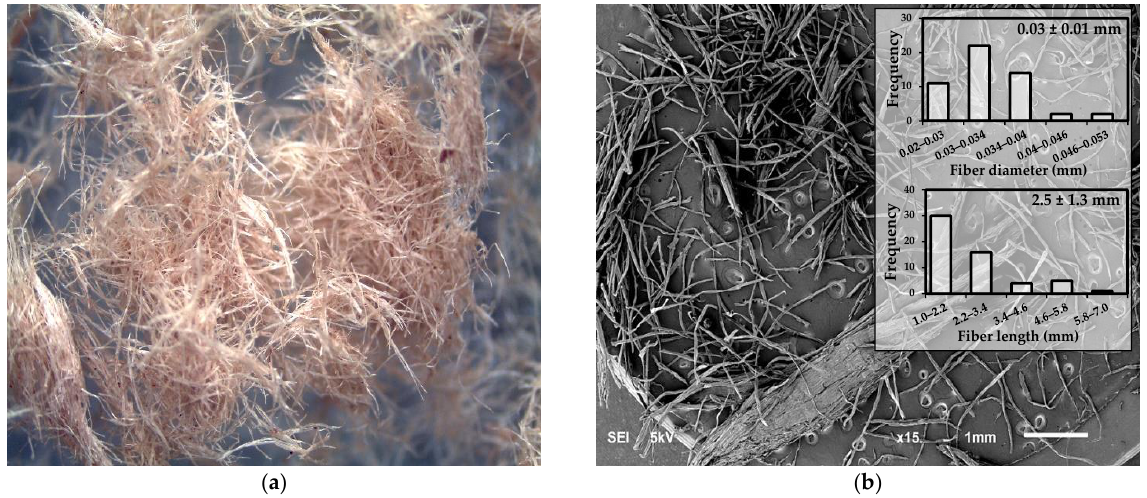
Figure 4. TMP. ( a ) Stereo microscopy imaging (35×); ( b ) SEM micrograph (15×).